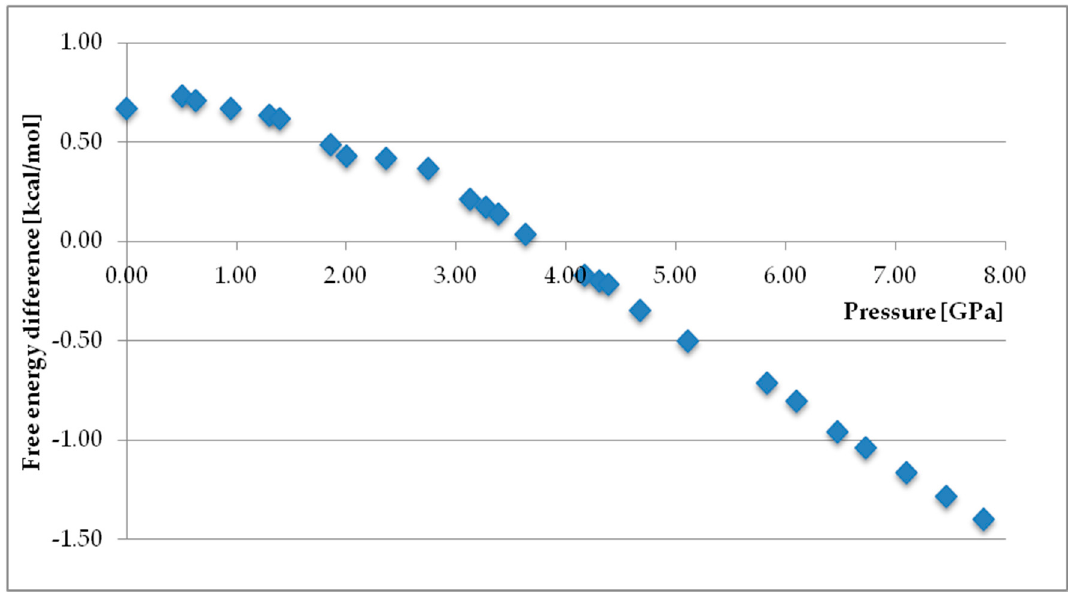
Figure 4. Results of thermodynamics calculations at constant temperature (298 K) and variable pressure for crystalline glycine, the differences between the free energy of δ and α polymorphs. Calculated values support the experimentally observed high pressure induced phase transition of α to δ polymorph. Source: author’s archive, more details [139].